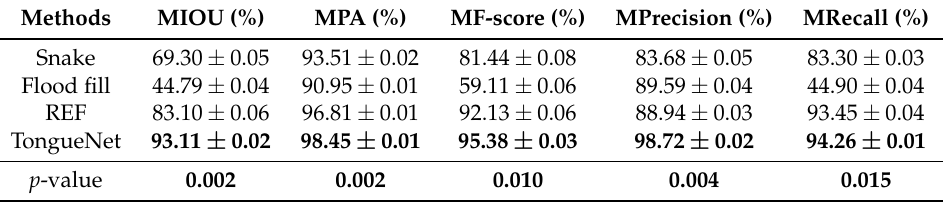
Table 4. Comparison of TongueNet with other segmentation methods (the significance level β = 0.05) Methods